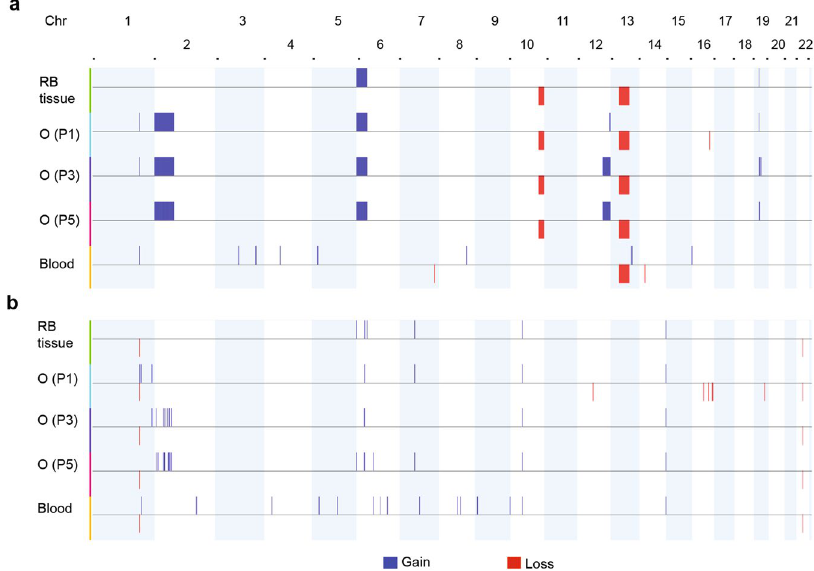
Figure 3. DNA copy number landscape of patient-derived retinoblastoma organoid line. ( a , b ) Copy number aberration of regional gains and losses ( > 3 Mb) ( a ) and focal lesions ( < 3 Mb) ( b ) in retinoblastoma (RB) tissue, RB688 organoids (O) at passage 1 (P1, 6-week culture), 3 (P3, 13-week culture), and 5 (P5, 19-week culture), matched with peripheral blood. See Fig. S3 for the frequency of gains or losses in tissue and